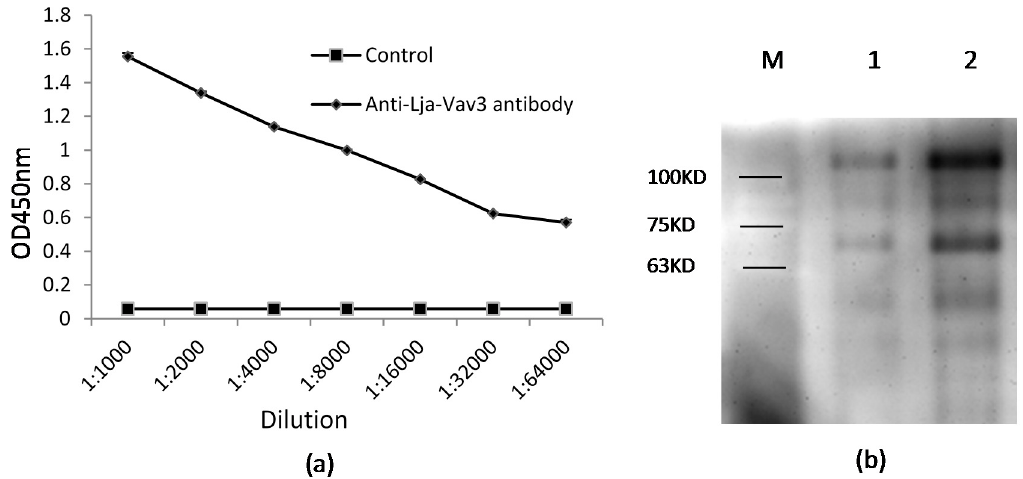
Figure A2. Titer and speci fi city analysis of the pAb against recombinant lamprey Vav3. ( a ) Determination of the titer of anti-recombinant lamprey Vav3 pAb by ELISA method. The anti-recombinant lamprey Vav3 pAb and negative control (rabbit IgG) were serially diluted to 64,000-fold in the same way, and the signal of each dilution was detected by three independent experiments; ( b ) the speci fi city of the anti-recombinant lamprey Vav3 pAb was con fi rmed by Western blot method. M: molecular marker; lane 1: the puri fi ed recombinant lamprey Vav3 (5 ng); lane 2: the puri fi ed recombinant lamprey Vav3 (15 ng) ( n = 3).